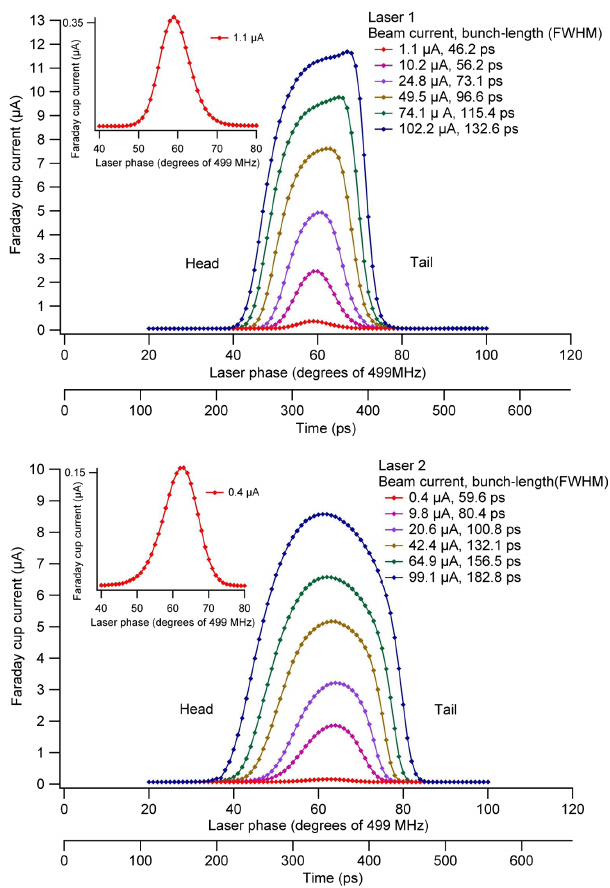
FIG. 3. Electron bunch-length measurements using the RF- deflector cavity, for RF-bunched beam at 499 MHz using “ laser 1 ” with 45 ps optical pulsewidth FWHM (top) and 249.5 MHz using “ laser 2 ” with 60 ps optical pulsewidth FWHM (bottom), for average beam current ranging from 1 to 100 μ A. The insets provide more detail for the lowest current measure- ments which suffer the least amount of space charge induced bunch-length growth, and therefore most closely resemble the laser optical pulse